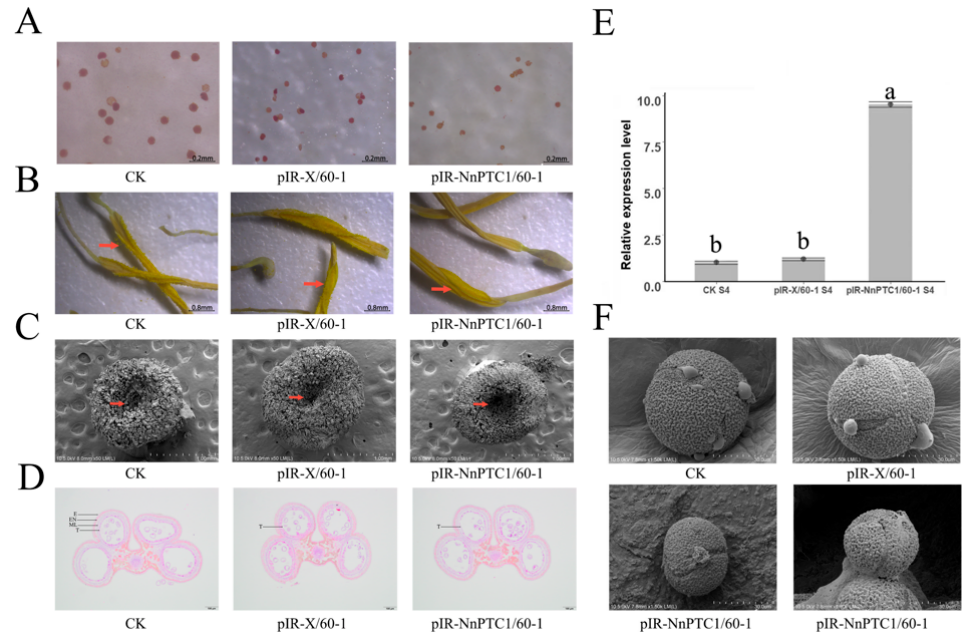
Figure 6. Pollen development of ‘Jinfurong 1’ after transient transformation of NnPTC1 overexpression. ( A ) Pollen grain staining of ‘Jinfurong1’ after transient transformation. ( B ) Pollen grain of ‘Jinfurong 1’ spread on the anther surface after transient transformation. Red arrows point to the anther surface. ( C ) Pollen grain germination on stigma of ‘Jinfurong 1’ after artificial self-pollination after transient transformation, red arrow points to stigma mouth, and all samples were taken 6 h after artificial pollination. ( D ) Structure of anther of ‘Jinfurong1’ at microspore mononuclear stage after transient transformation. E, epidermal layer; ML, middle layer; En, endothecium; T, tapetum. ( E ) Expression of NnPTC1 after transient transformation. ( F ) Pollen grain morphology of ‘Jinfurong 1’ after transient transformation.